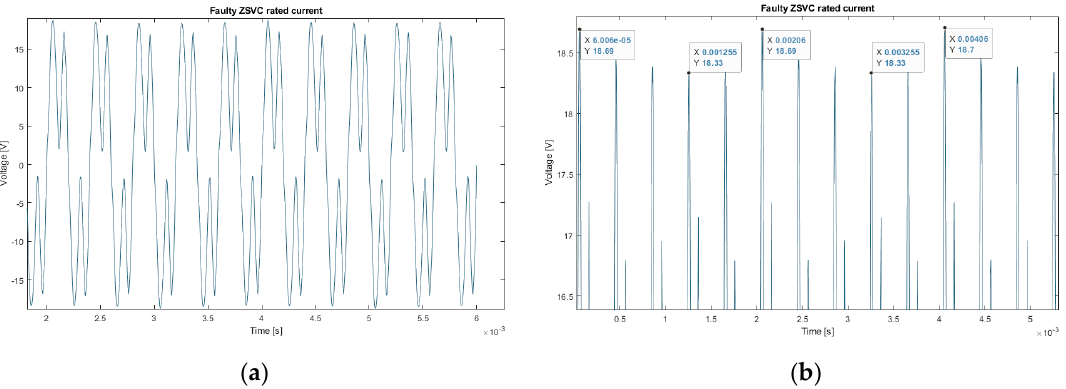
Figure 7. ZSVC of the analyzed fPMa-SynRM when operating at rated conditions. ( a ) Waveform of the ZSVC. ( b ) Zoom of (a).